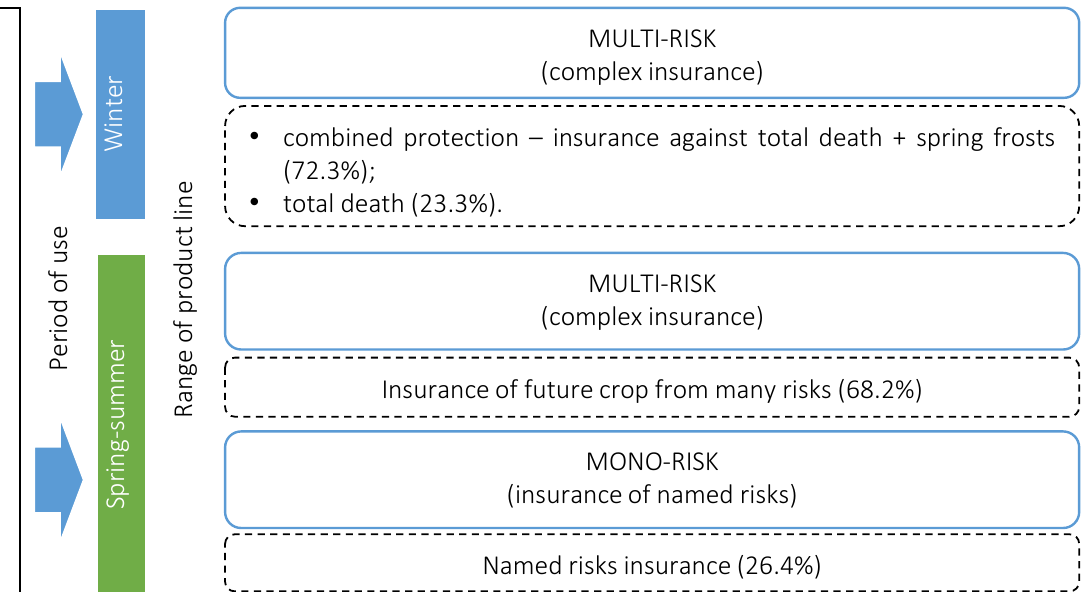
Figure 11. Set of the classical (traditional) insurance products used in agrarian enterprises of Ukraine in 2017 in the context of seasonal gradation